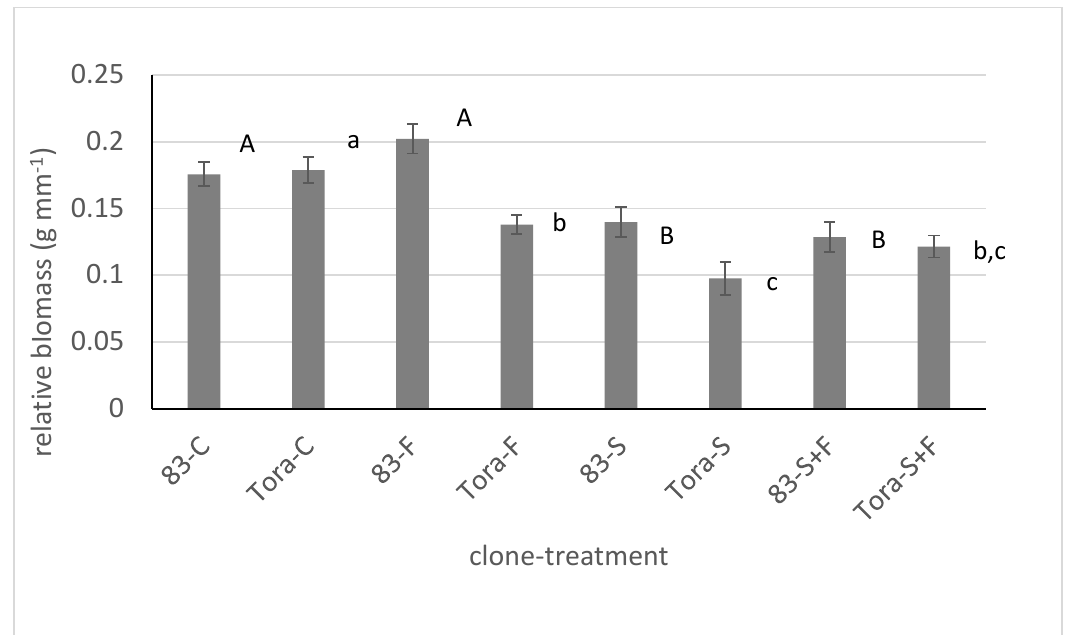
Figure 2. The average relative biomass production, at four-week harvest, by cuttings originating from different clones and treatments (C—control; F—fertilizer, S—soil; S+F—soil and fertilizer) in 2009. The bars represent SE ( n = 14–15). The particular clone values with distinct letters (capitals for clone 83 and lowercase for clone Tora) differ from each other significantly (REGW test).